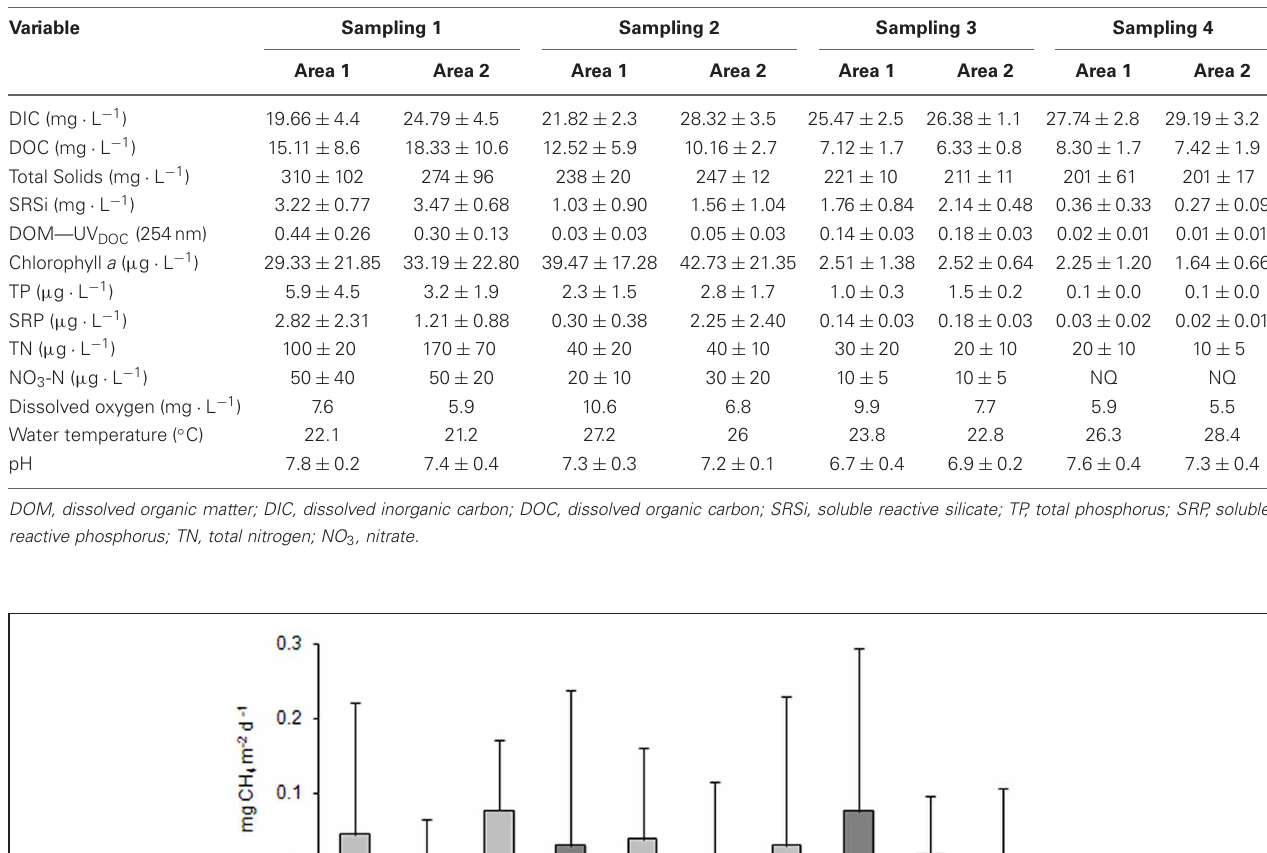
Table 2 | Results of analyses of water from the water/sediment interface samples.